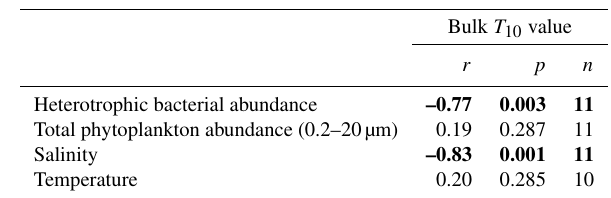
Table 2. Correlations between biological and physical properties of bulk seawater and T 10 values for 2016. Values in bold indicate results that are statistically